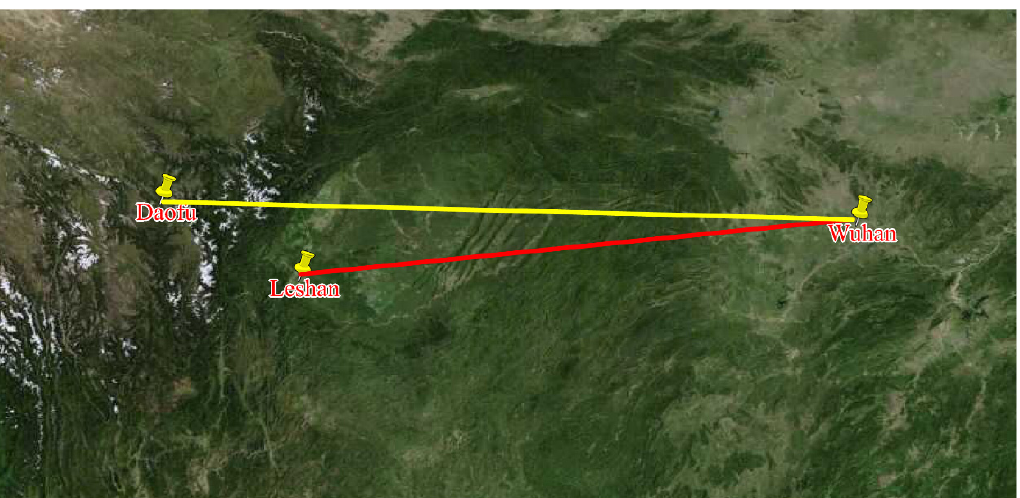
Figure 1. Site distribution of the experimental scheme.